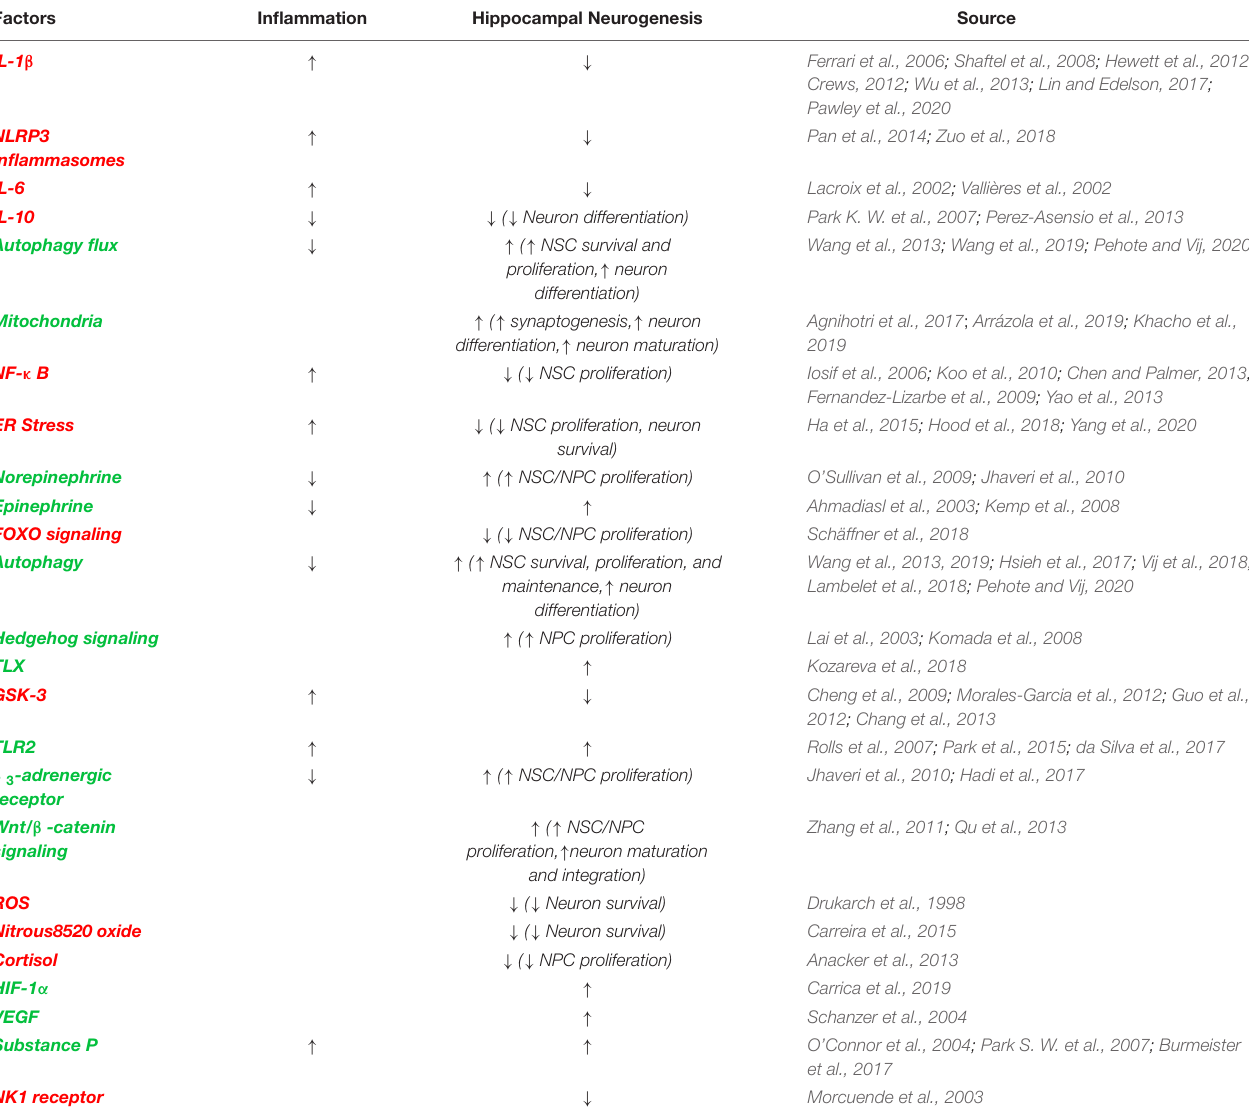
TABLE 2 | Factors, signaling molecules, hormones and activities following SCI that impact hippocampal neurogenesis and inflammation in some cases.